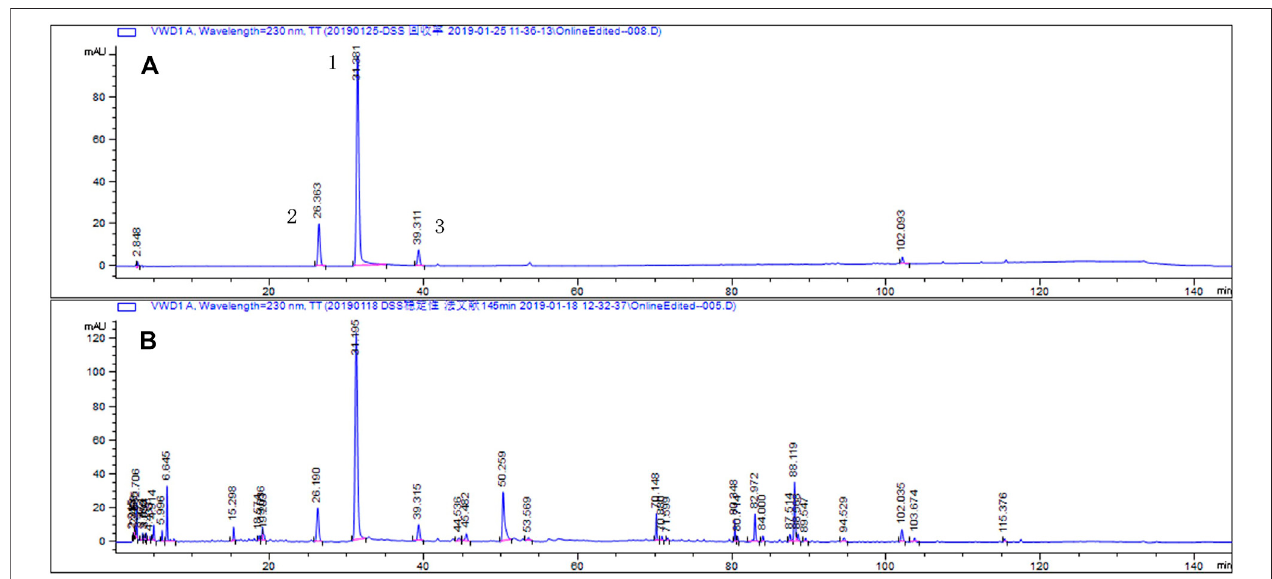
FIGURE 7 | Representative chromatograms of standard compounds (A) and DSS ethanol extract (B) analyzed by HPLC-UV. 1) paeoni fl orin; 2) alibi fl orin; 3) feuric acid.